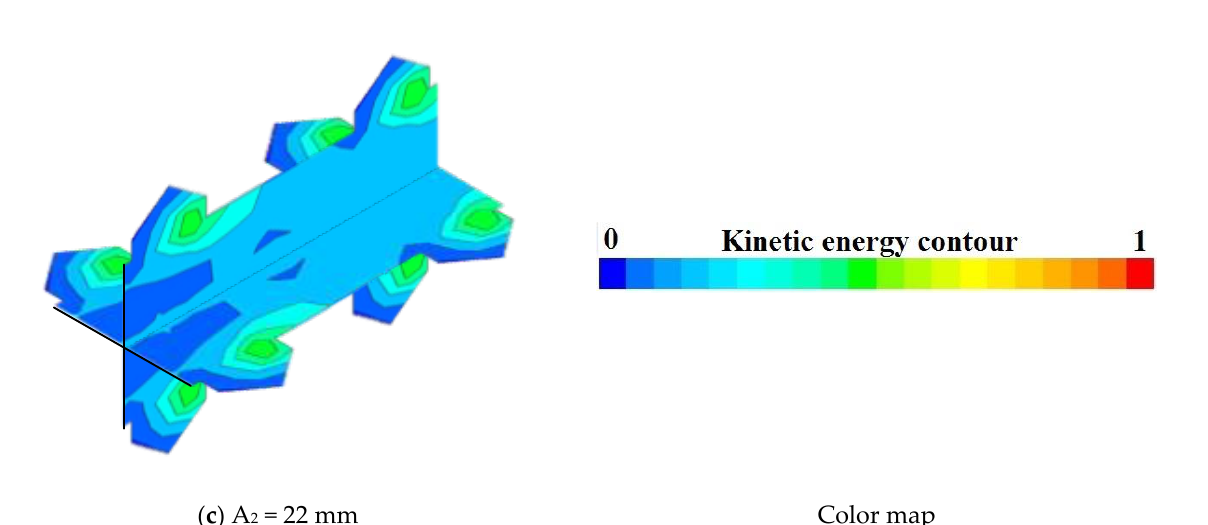
Figure 10. Kinetic energy contours for various configurations of Case A with different A 2 parameters at R = 15 mm, Re = 15,000, and 𝜑 = 0.5%.